Question: Does the plotted quantity increase or decrease?
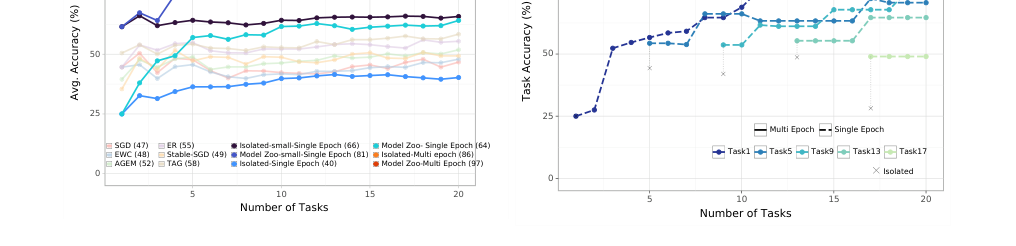
Answer: increasing